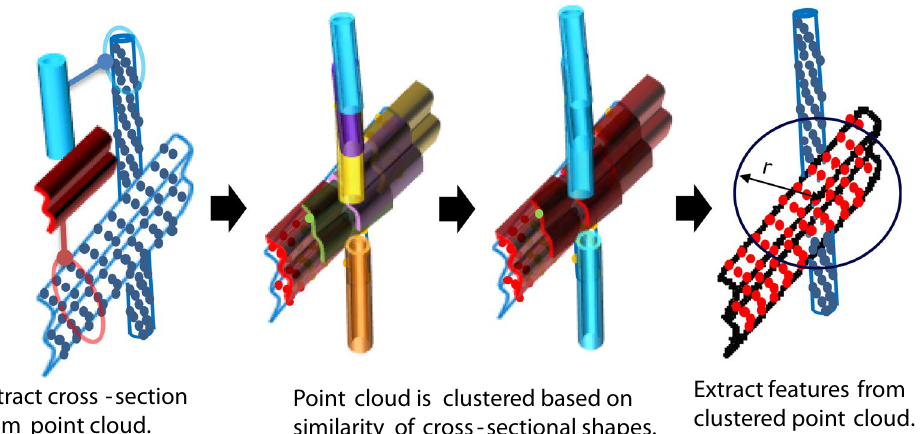
Extract cross -section